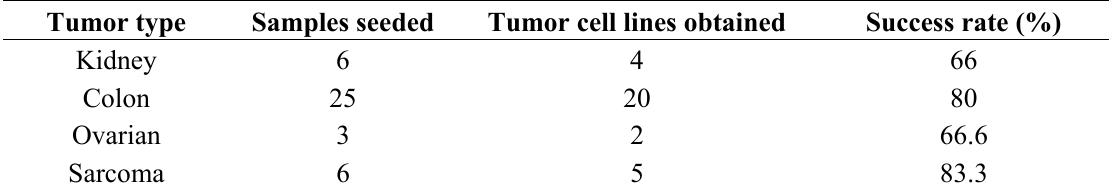
Table 2. Primary cultures from solid tumors disaggregated with GentleMacs. Tumor type Samples seeded Tumor cell lines obtained Success rate (%) Kidney 6 66 Colon 25 Ovarian 66.6 Sarcoma 83.3